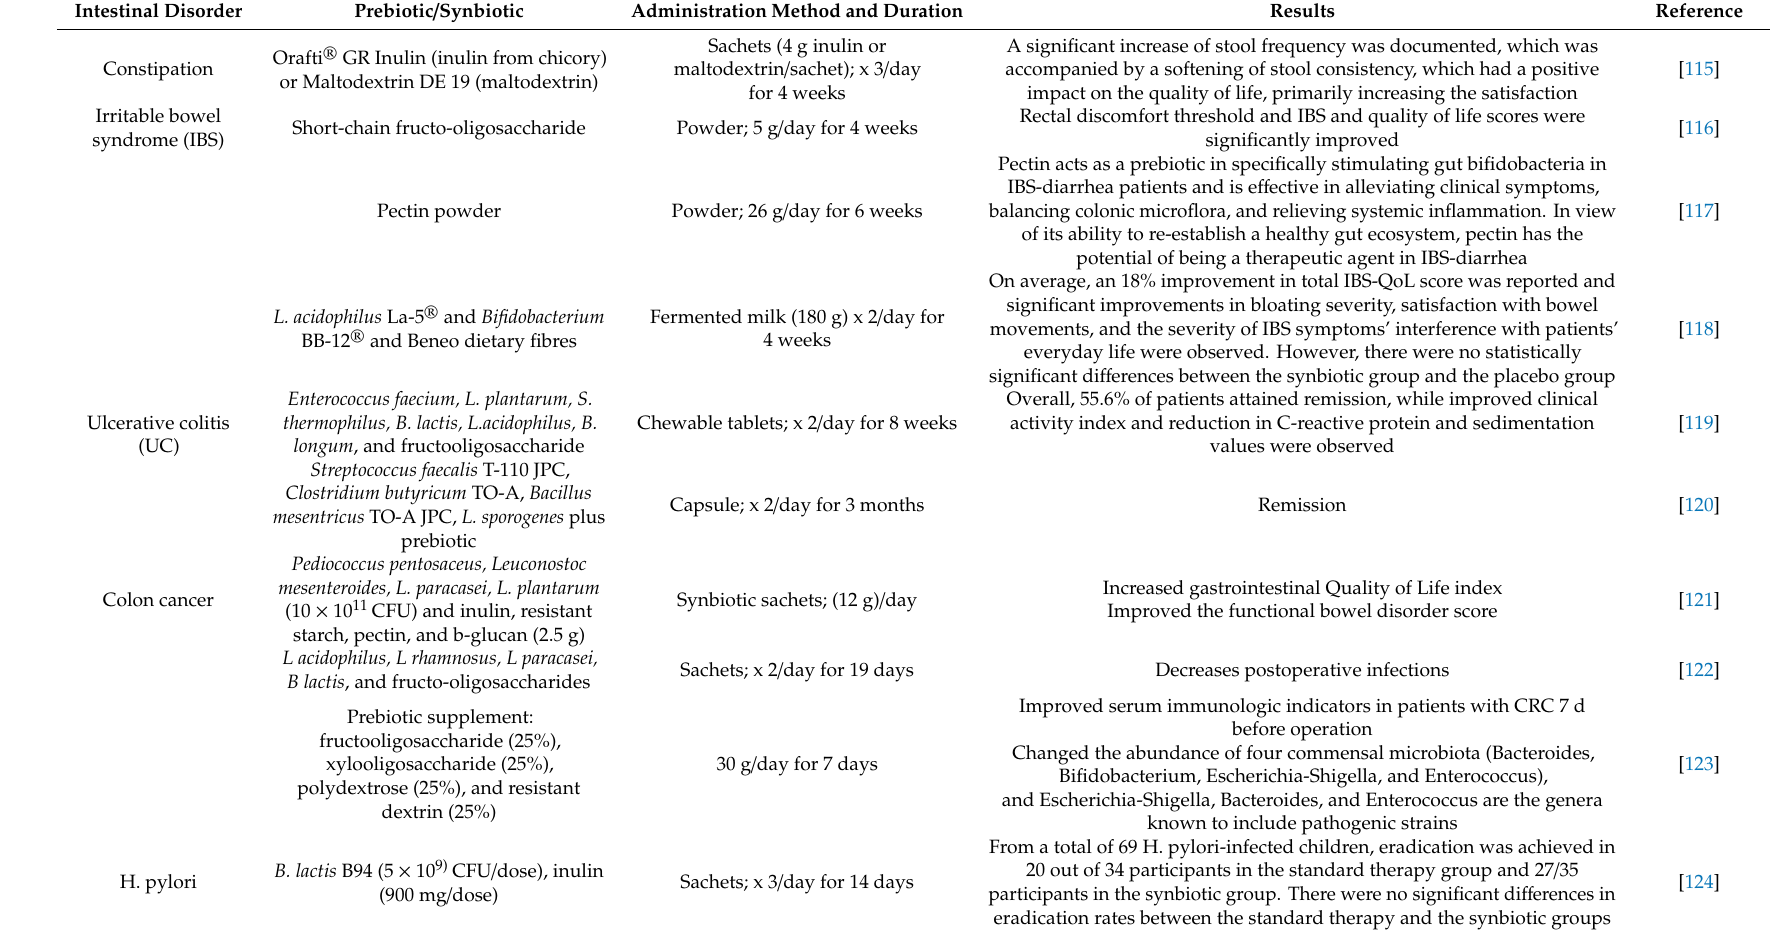
Table 2. Prebiotics in intestinal